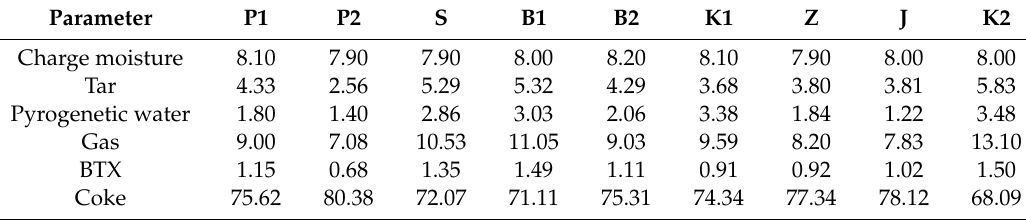
Table 3. The mass shares of pyrolysis process products (laboratory installation), wt